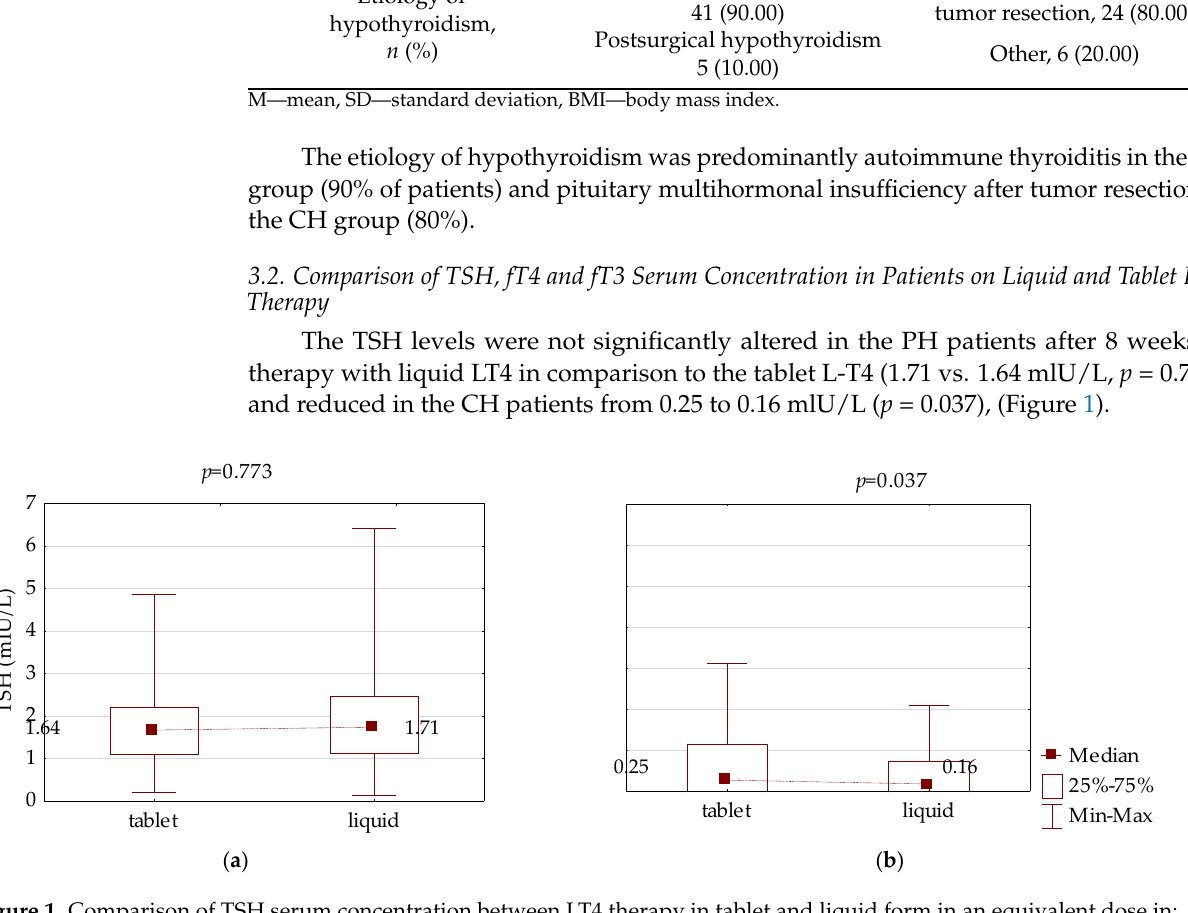
( b ) Figure 2. Comparison of fT4 serum concentration between LT4 therapy in tablet and liquid form in an equivalent dose in: ( a ) primary hypothyroidism and ( b ) central hypothyroidism. Moreover, fT3 concentration in the PH patients increased from 2.82 pg/mL when measured during therapy with LT4 in tablet form to 3.15 pg/mL after 8 weeks of therapy with liquid LT4 ( p < 0.001). In the CH patients, fT3 concentration remained stable over time (2.69 vs. 2.74 pg/mL on average; p = 0.447) (Figure 3).